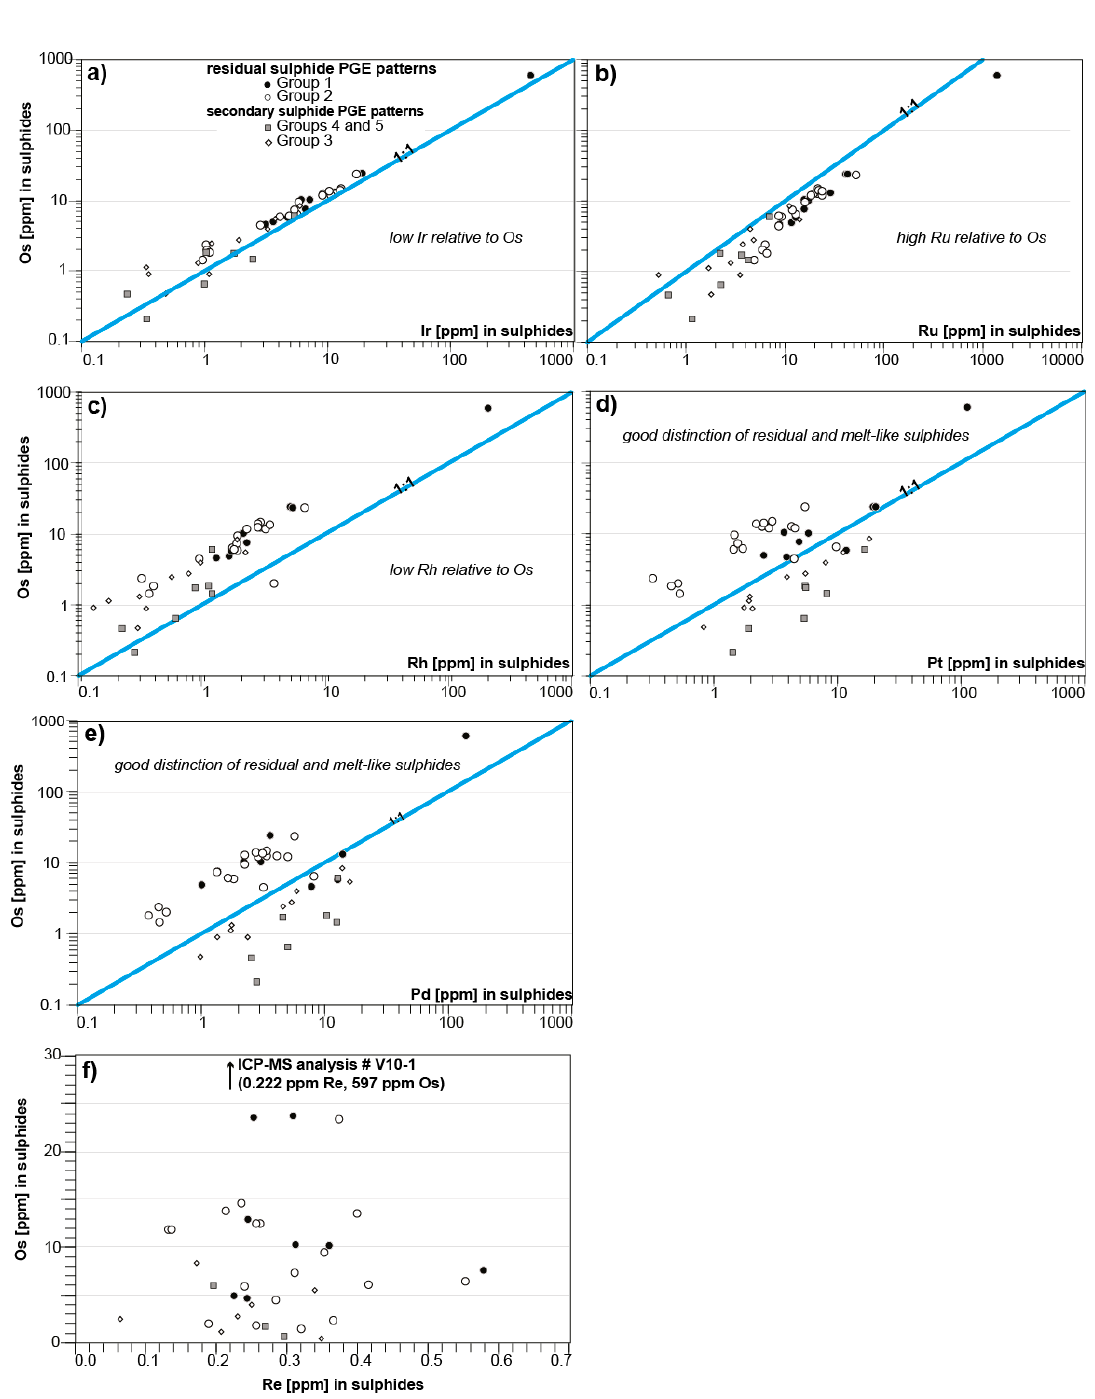
Figure 4. The abundances of Ir ( a ), Ru ( b ), Rh ( c ), Pt ( d ), Pd ( e ), and Re ( f ) in mss and pentlandites plotted against Os. IPGEs (Os, Ir, Ru) are well correlated along a 1:1 line, while Rh abundances are higher relative to Os. Pt and Pd are less well correlated with Os. Rhenium and Os do not display a systematic trend. PGE patterns are grouped as residual for [Pd / Ir] N < 1 and secondary for [Pd / Ir] N > 1. Residual PGE patterns are further subdivided on the basis of their [Pt / Pd] N ratios (group 1: Pt N > Pd N ; group 2: Pt N < Pd N ). Subgroups of secondary PGE patterns are group 3 (unfractionated PGE pattern), group 4 (melt-like PGE pattern), and Group 5 (incomplete PGE inventory). Also see text for more details on the groupings.